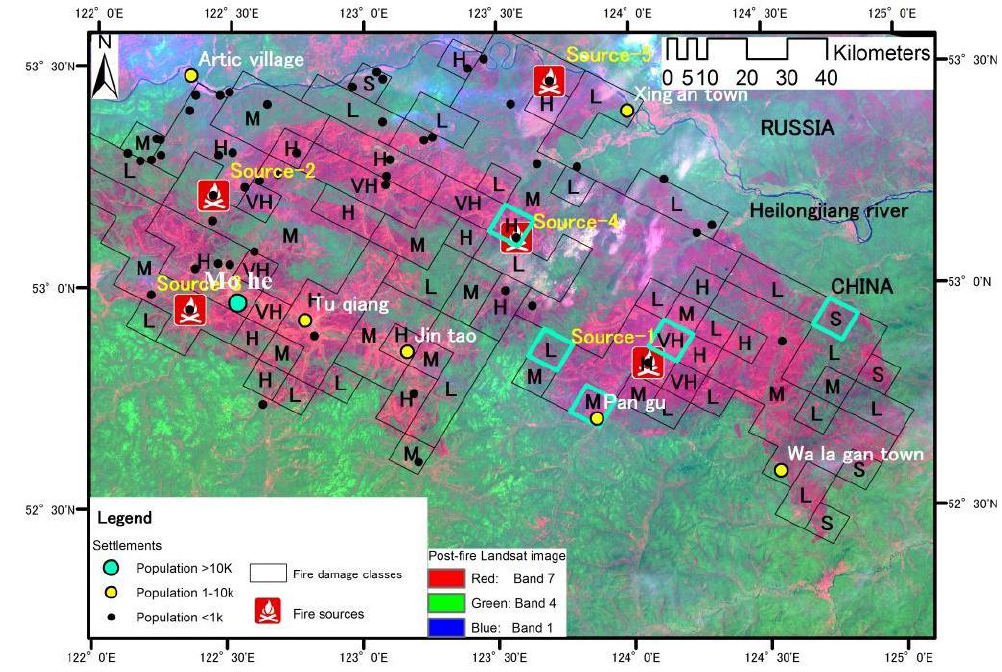
Figure 4. Fire sources and fire damage classes: Very high (VH), High (H), Moderate (M), Low (L) and Slight (S). The base map image is a composition of two Landsat 5 TM images from June 1987 (false color composite bands: red-band 7; green-band 4; blue-band 1). Beryl green grids were chose to track the detail vegetation signals using Landsat images with 30 m spatial resolution.